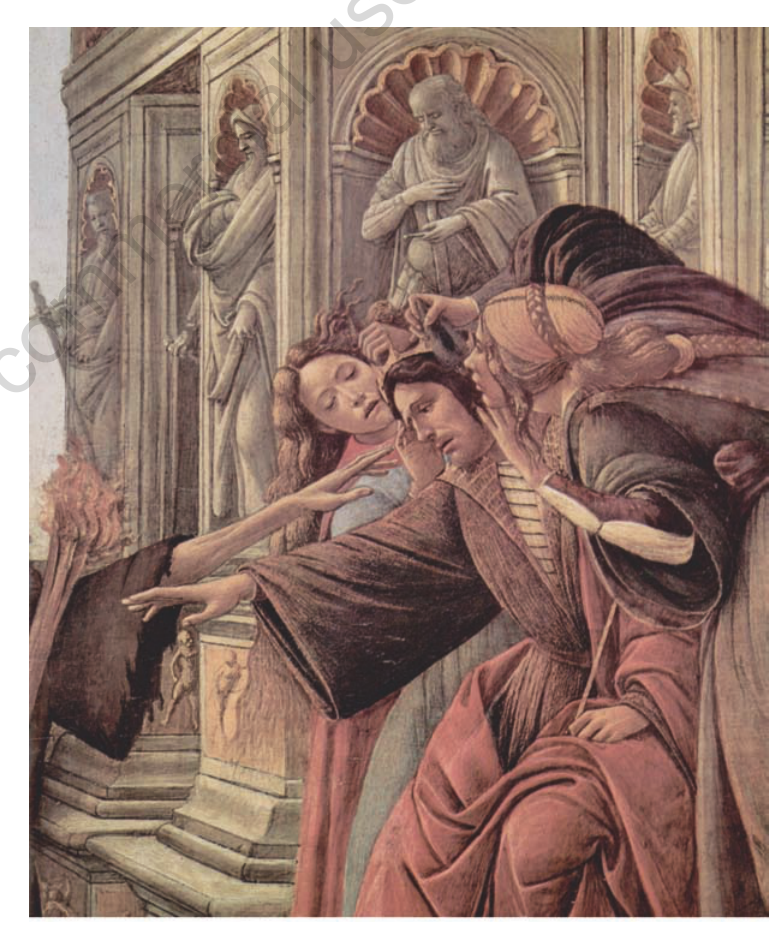
Figure 1. “The Calumny of Apelles” painting (detail) by Sandro Botticelli showing left hand of the character Envy with wasted first dorsal interosseous, dropped fourth and fifth digit, and atrophied muscle in